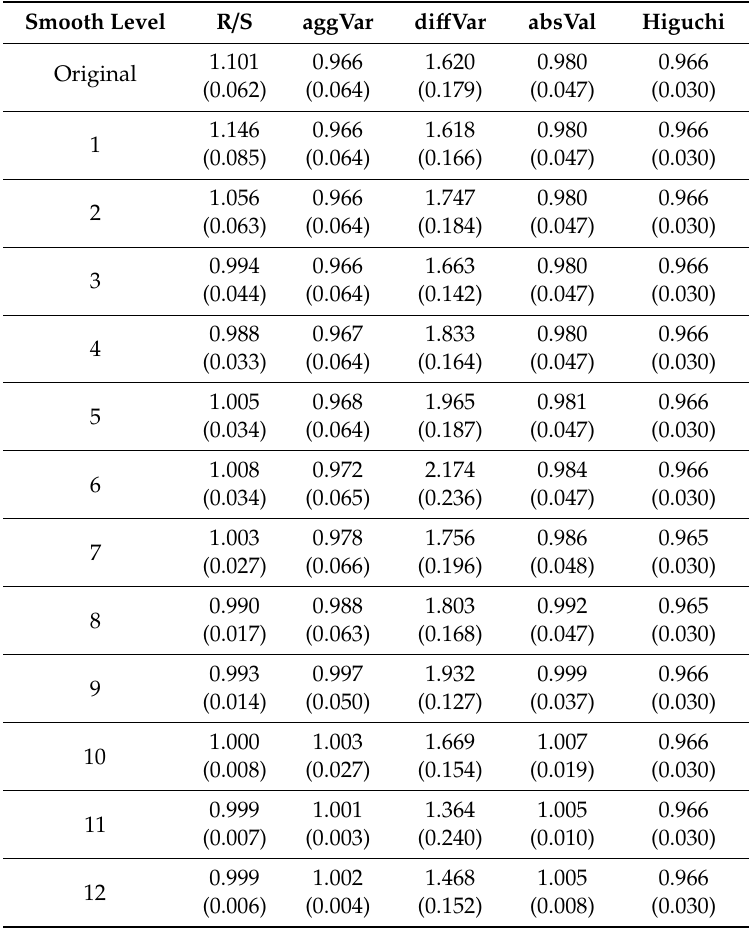
Table 3. Long-memory parameter estimates of exchange-rate volatility at di ff erent horizons. Smooth